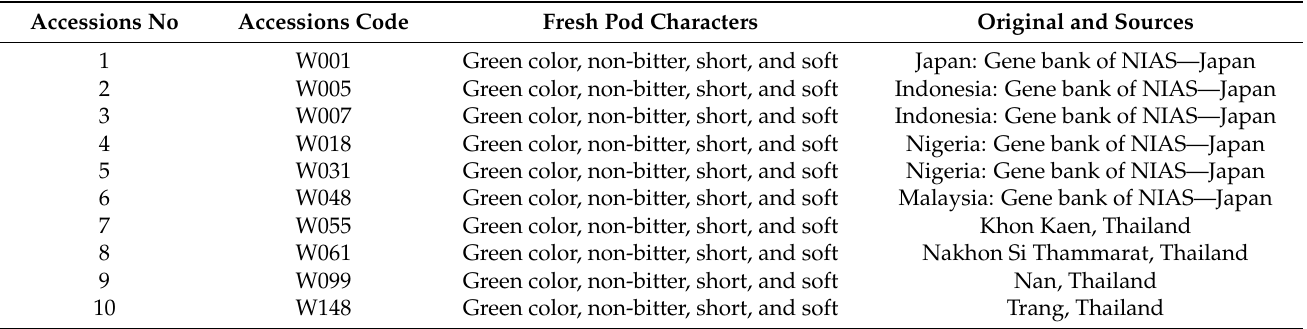
Table 6. The origins and sources of the ten selected winged beans used in this